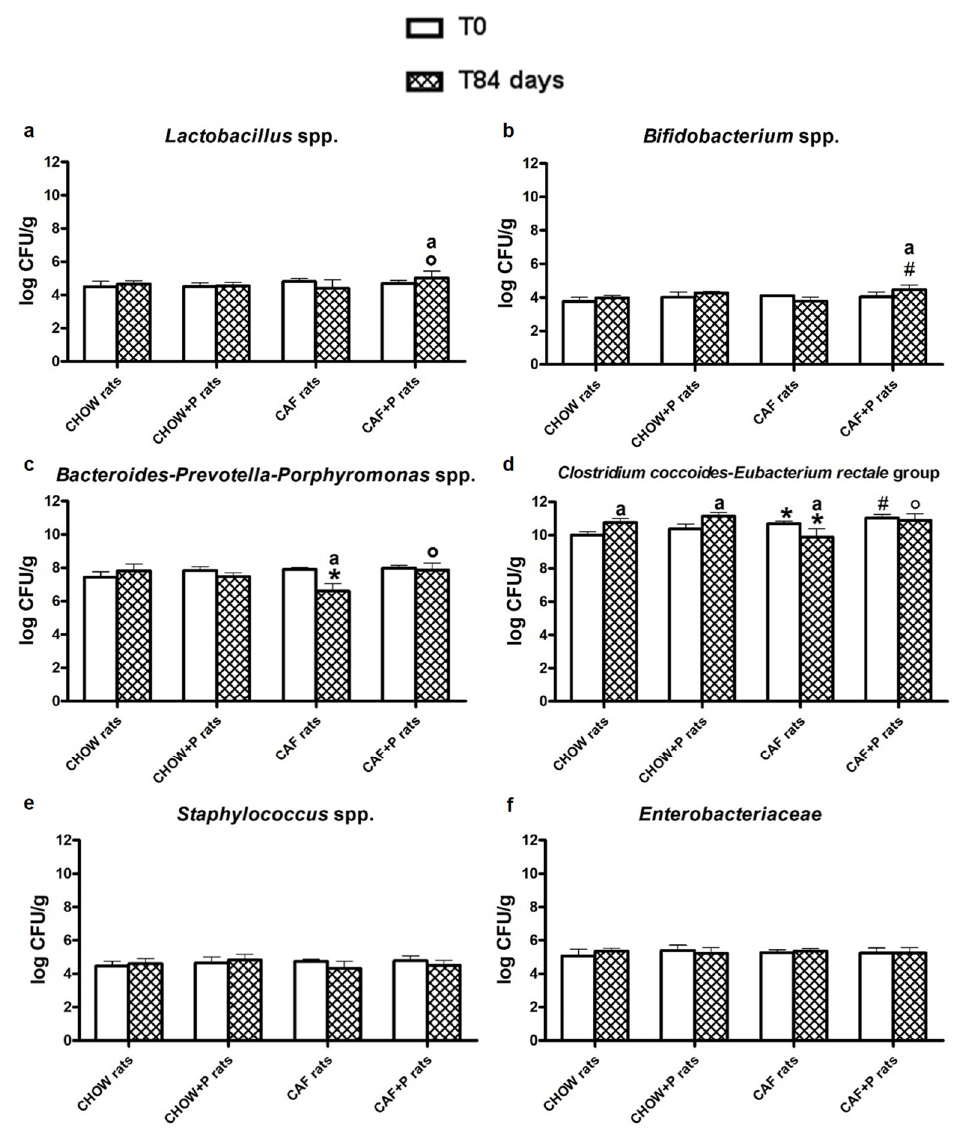
Figure 3. Fecal microbiota composition quantified by Real-Time PCR: ( a ) Lactobacillus spp.; ( b ) Bifidobacterium spp.; ( c ) Bacteroides-Prevotella-Porphyromonas spp.; ( d ) Clostridium coccoides- Eubacterium rectale group ( e ) Staphylococcus spp. and ( f ) Enterobacteriaceae in all groups of rats at the beginning of the experimental period (T0) and after 84 days of probiotic supplementation (T84). Data are shown as means ± SD of 6–9 rats per group. One-way ANOVA and Bonferroni test: * p < 0.05 vs. CHOW rats; ° p < 0.05 vs. CAF rats; # p < 0.05 vs. CAF+P rats; a p < 0.05 vs. T0. CAF: cafeteria; P: probiotic supplementation.